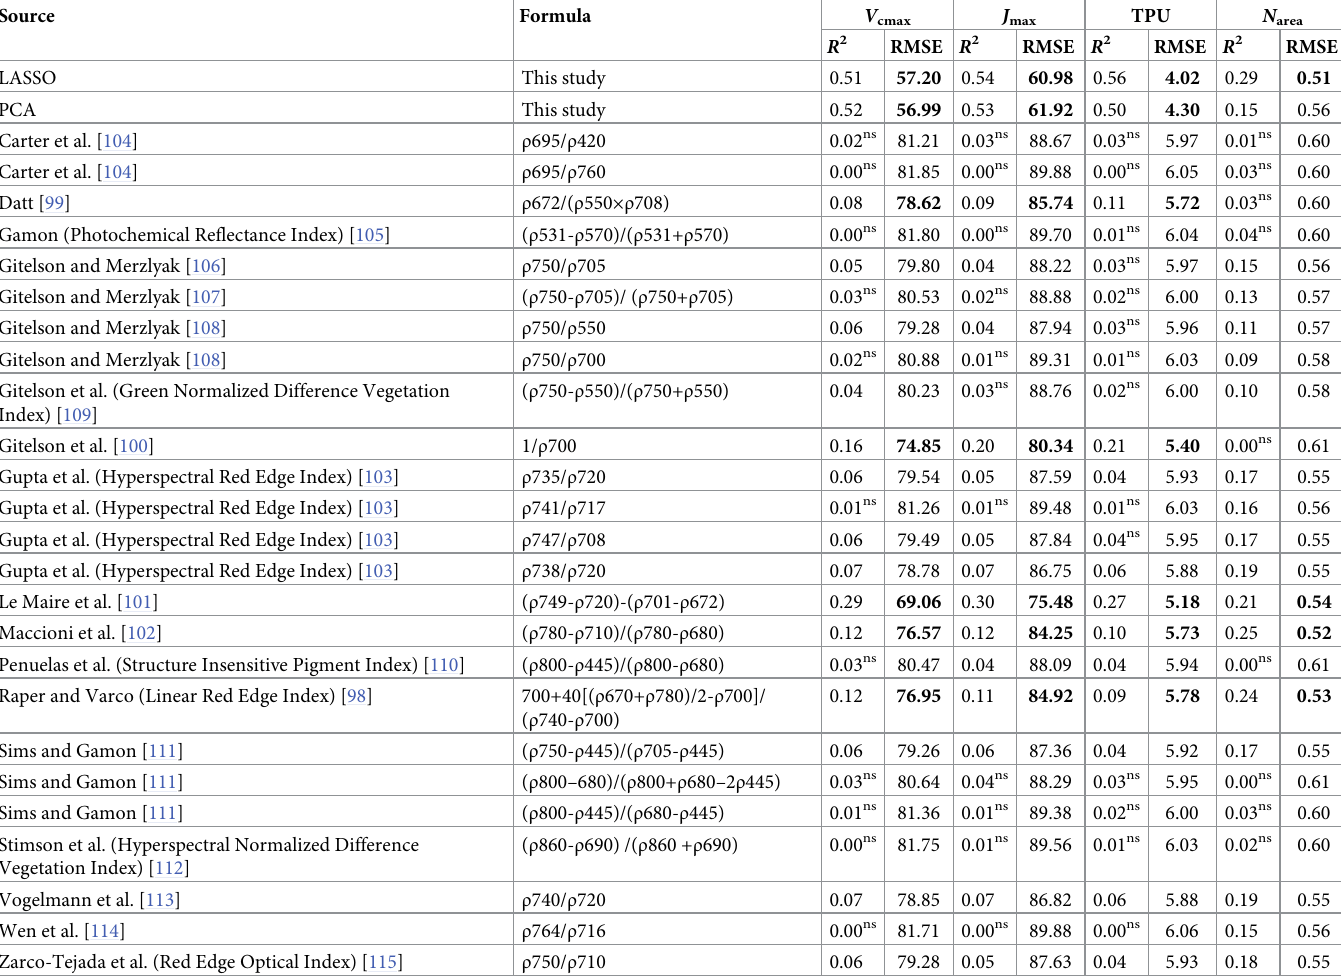
Table 3. Comparison of model performance among the LASSO model, the PCA model, and published vegetation